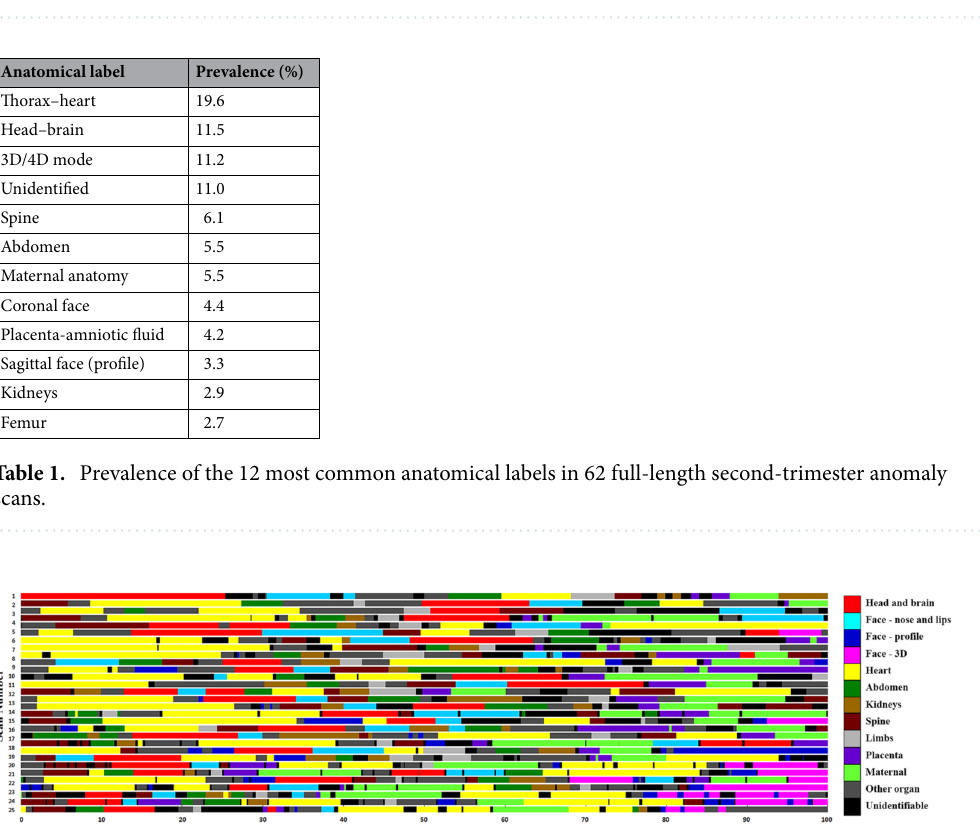
Figure 5. Confusion matrices for the comparison of scans labeling. ( A ) Scans labeled by different human annotators and ( B ) Scans manually labeled vs. those automatically labeled by a deep neural network. Figure created using the Python programming language (Python Software Foundation, https:// www. python. org/).